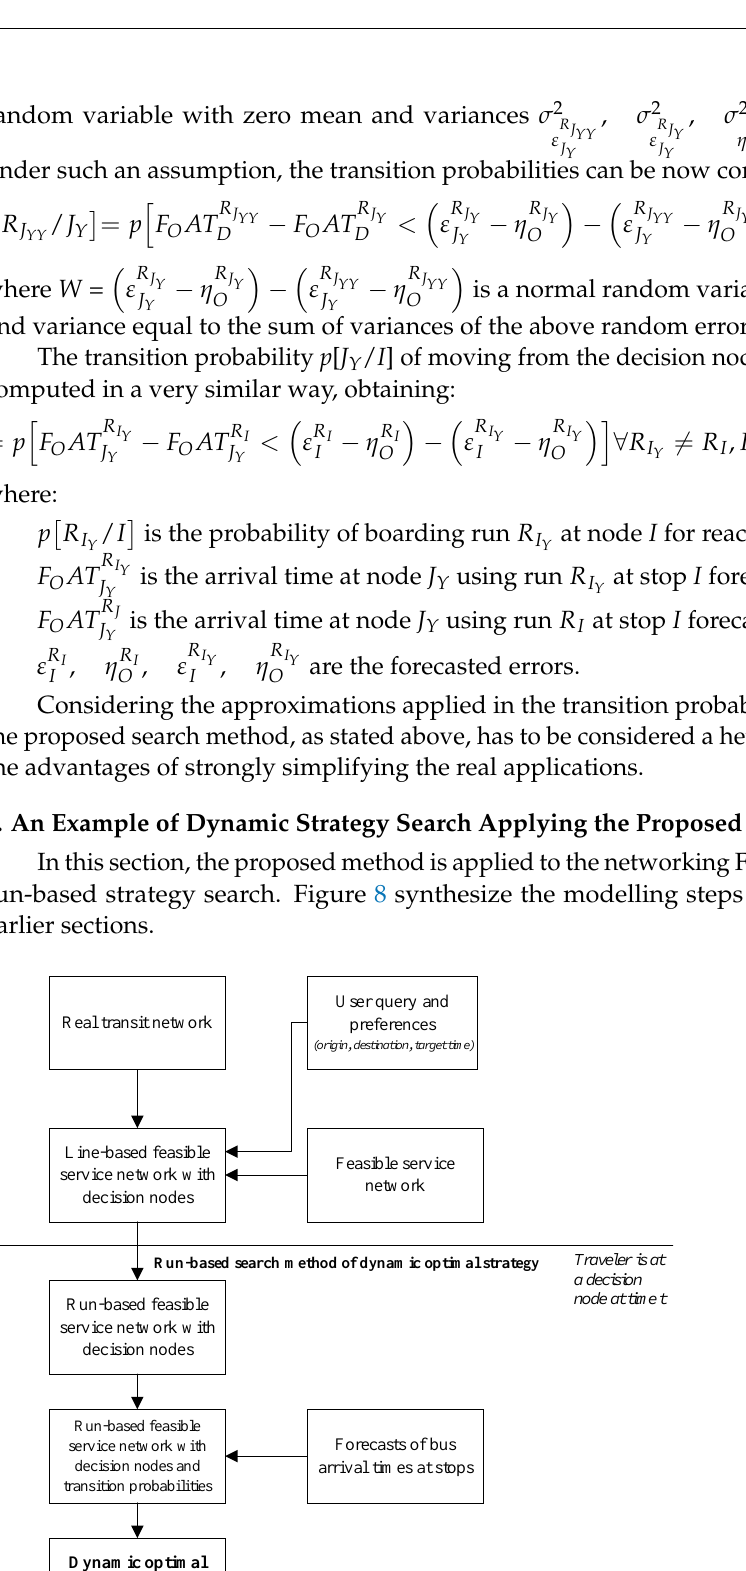
Figure 9. State action tree for the first boarding stops B and C. Table 3. Estimation of residual variance according to the forecasting horizon (refer to Figure 6). Random Residual